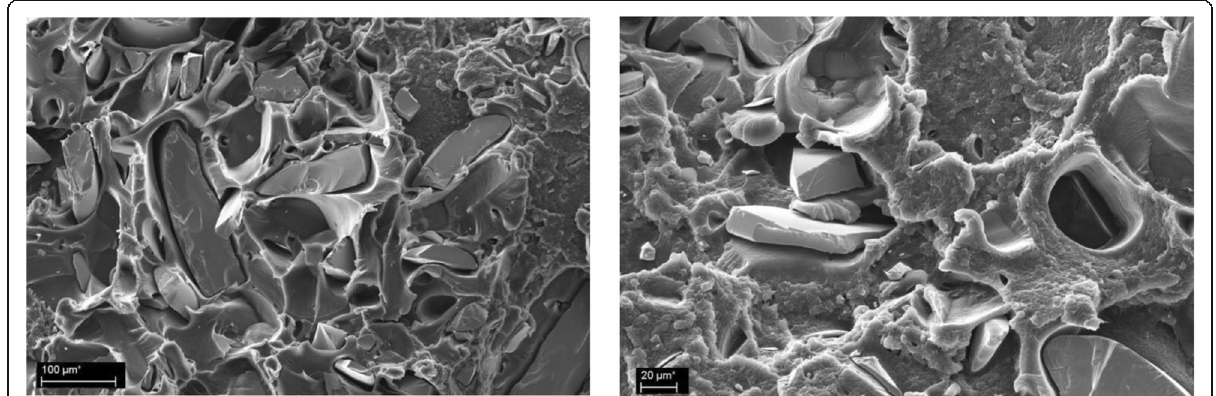
Fig. 7 Higher Magnification (150x) (left) and PEEK_50NdFeB (350x)(right) fracture surface